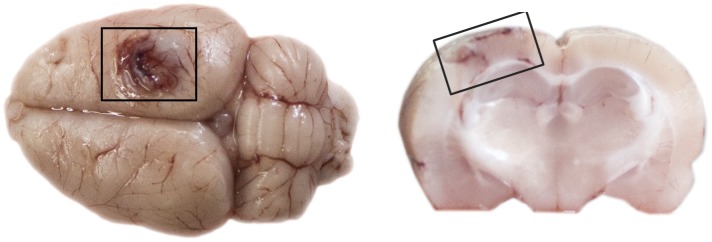
Rat models of traumatic brain injury were established. Boxed areas illustrate the traumatic tissue region that was sampled.